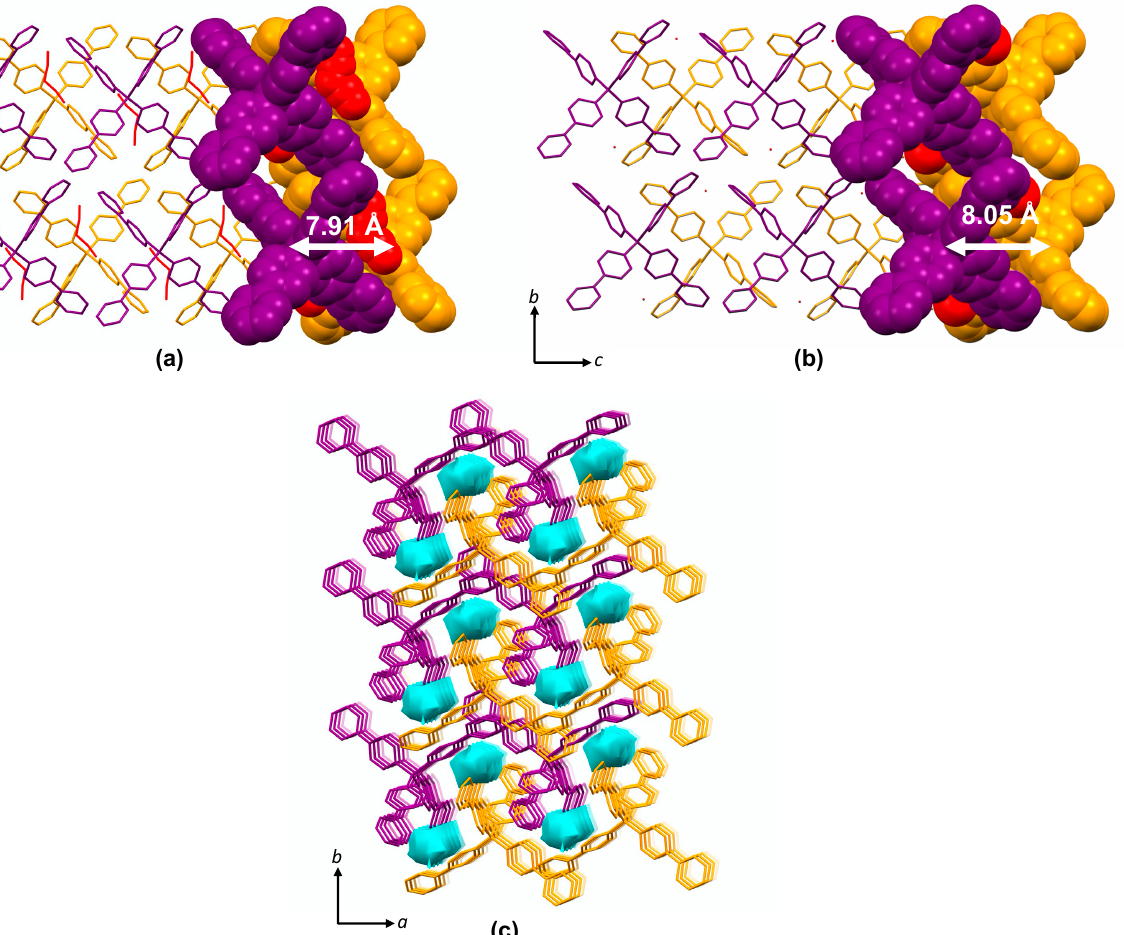
Figure 2. Partial space filling representation depicting the self-assembly of 1 ( a ) and 2 ( b ) viewed down the crystallographic a -axis. A phosphonium cation pair is highlighted as one purple and one orange species in each case, with closest P ··· P distances of 7.91 Å and 8.05 Å for 1 and 2 , respectively. Anions are highlighted in red space filling representations. Light blue surfaces represent the voids occupied by N(CN) 2 − anions in 1 , or Br − anions and solvent molecules in 2 . ( c ) Visualization of the calculated void volume within the crystal lattice of 1 is 45.4%. Similar packing arrangement with voids within the crystal lattice is found for 2 with a calculated void volume of 54.5%. Hydrogen atoms and solvent molecules are omitted for clarity.